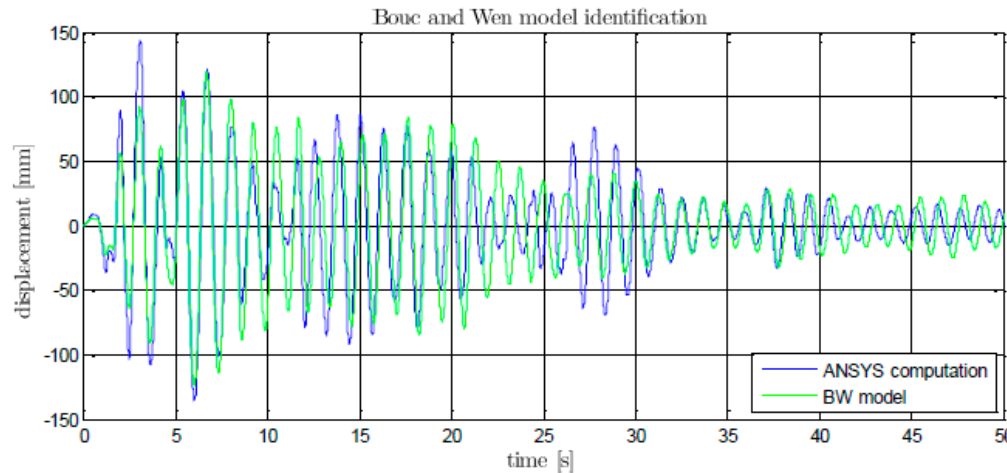
Figure 8: Displacement time history: comparison between BW identified model and ANSYS results (El Centro 1940